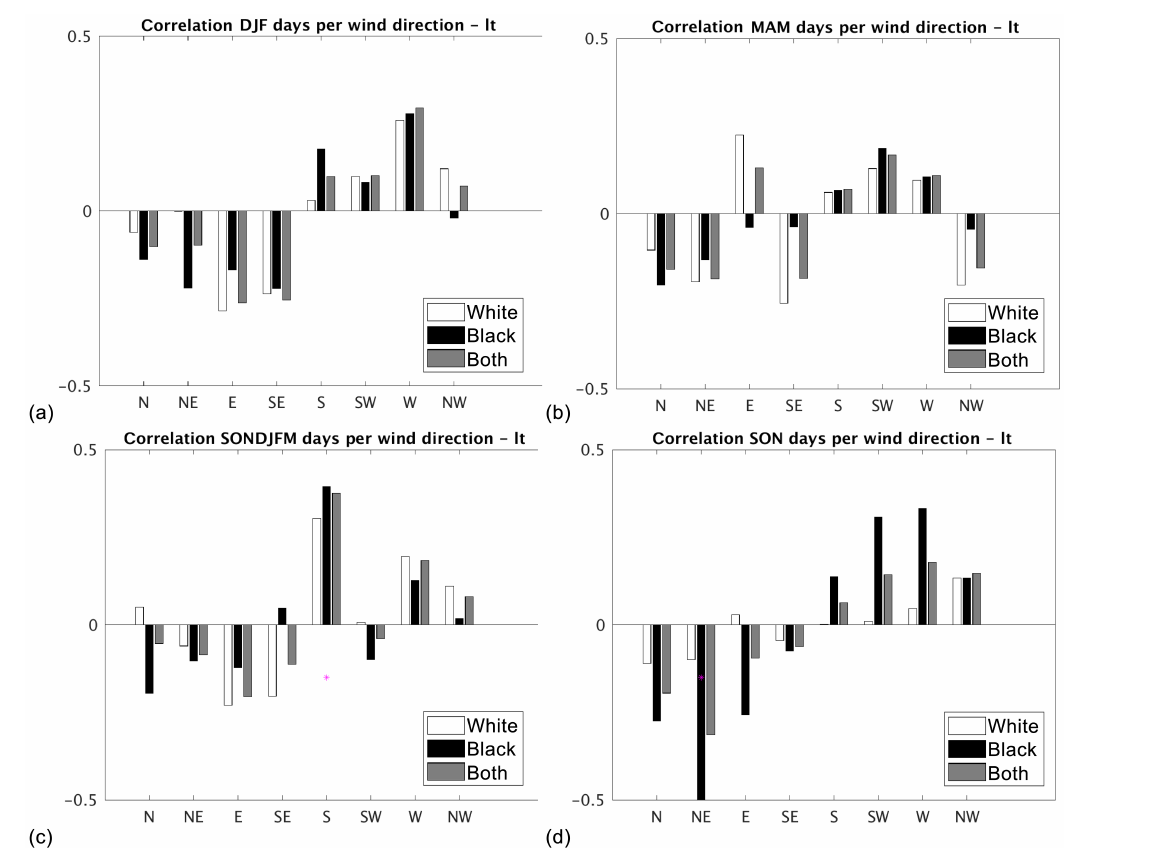
Figure 4. Correlation coefficients between the number of days per wind direction and the dune thickness (lt-layer thickness) of the white layer (white), black layer (black), and both together (grey). The correlations are shown for winter (DJF), spring (MAM), the windy season (SONDJFM), autumn (SON), and the eight wind directions. The correlations marked with * are significant at the 95%